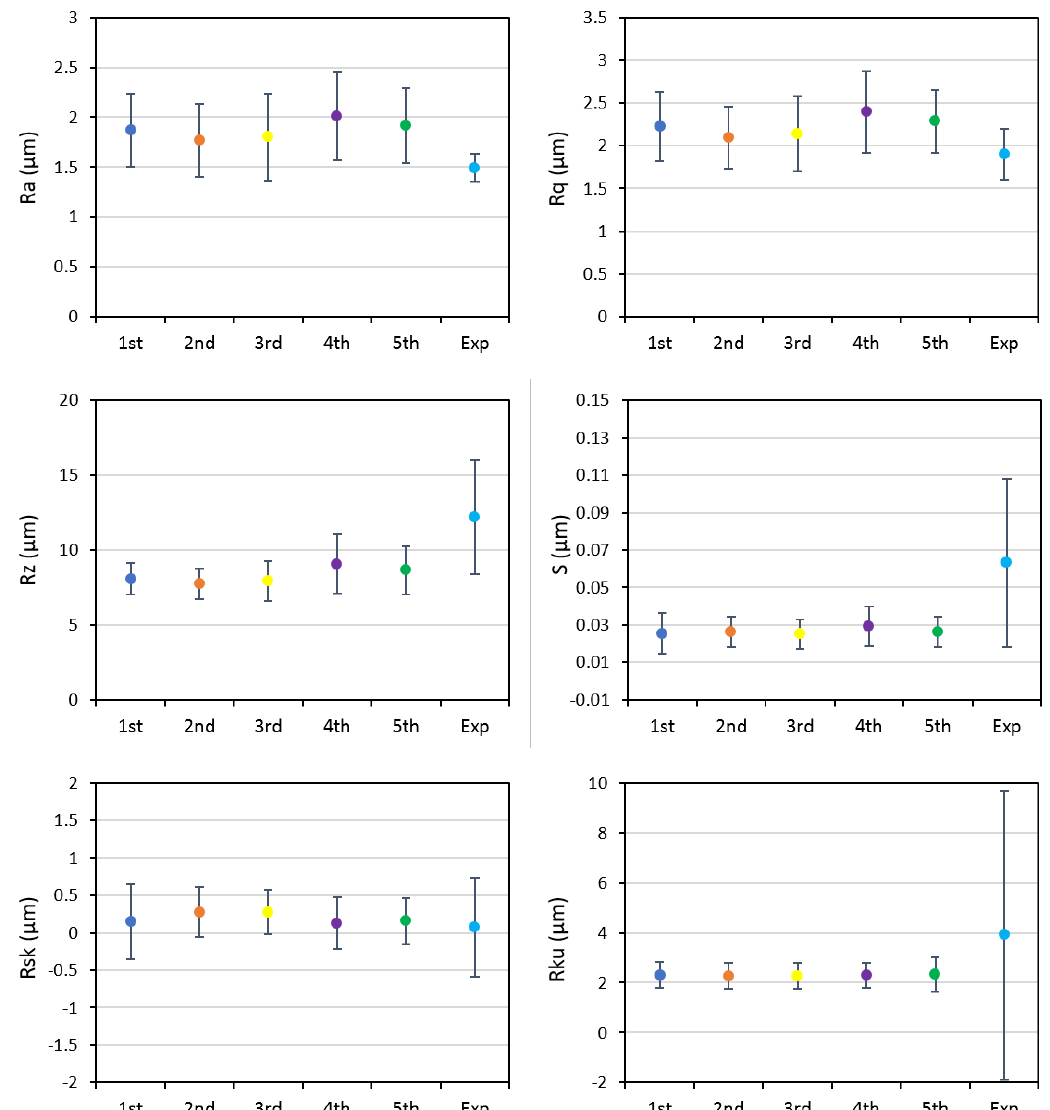
Figure 2. Comparison of profile parameters obtained from five different simulations and the experimental results for full coverage.